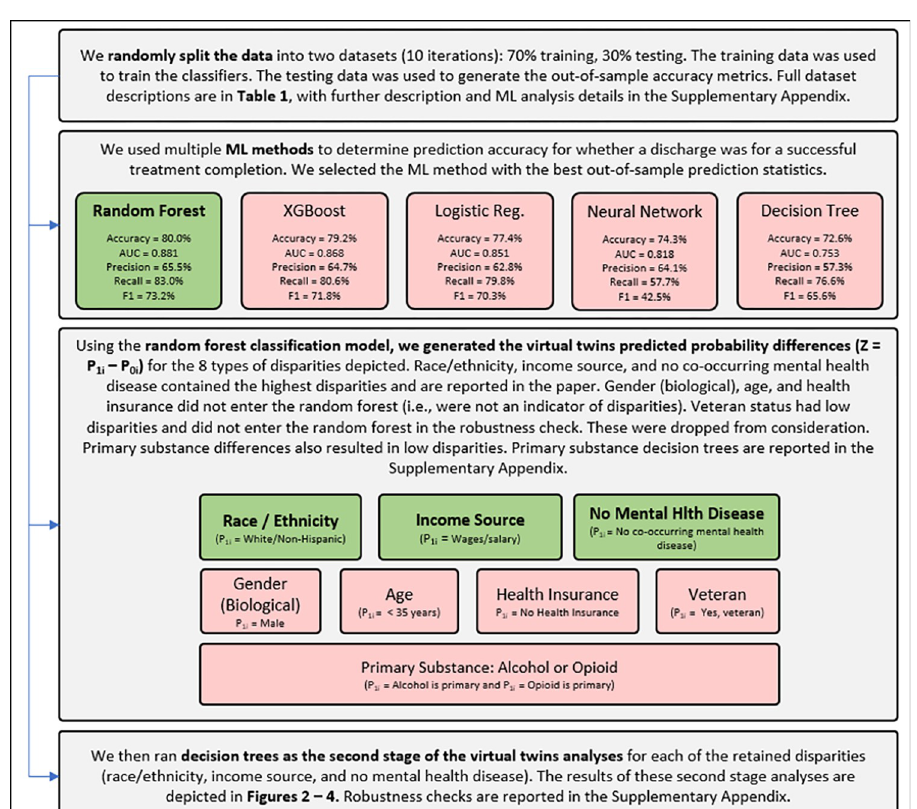
Fig 1. Research process flow